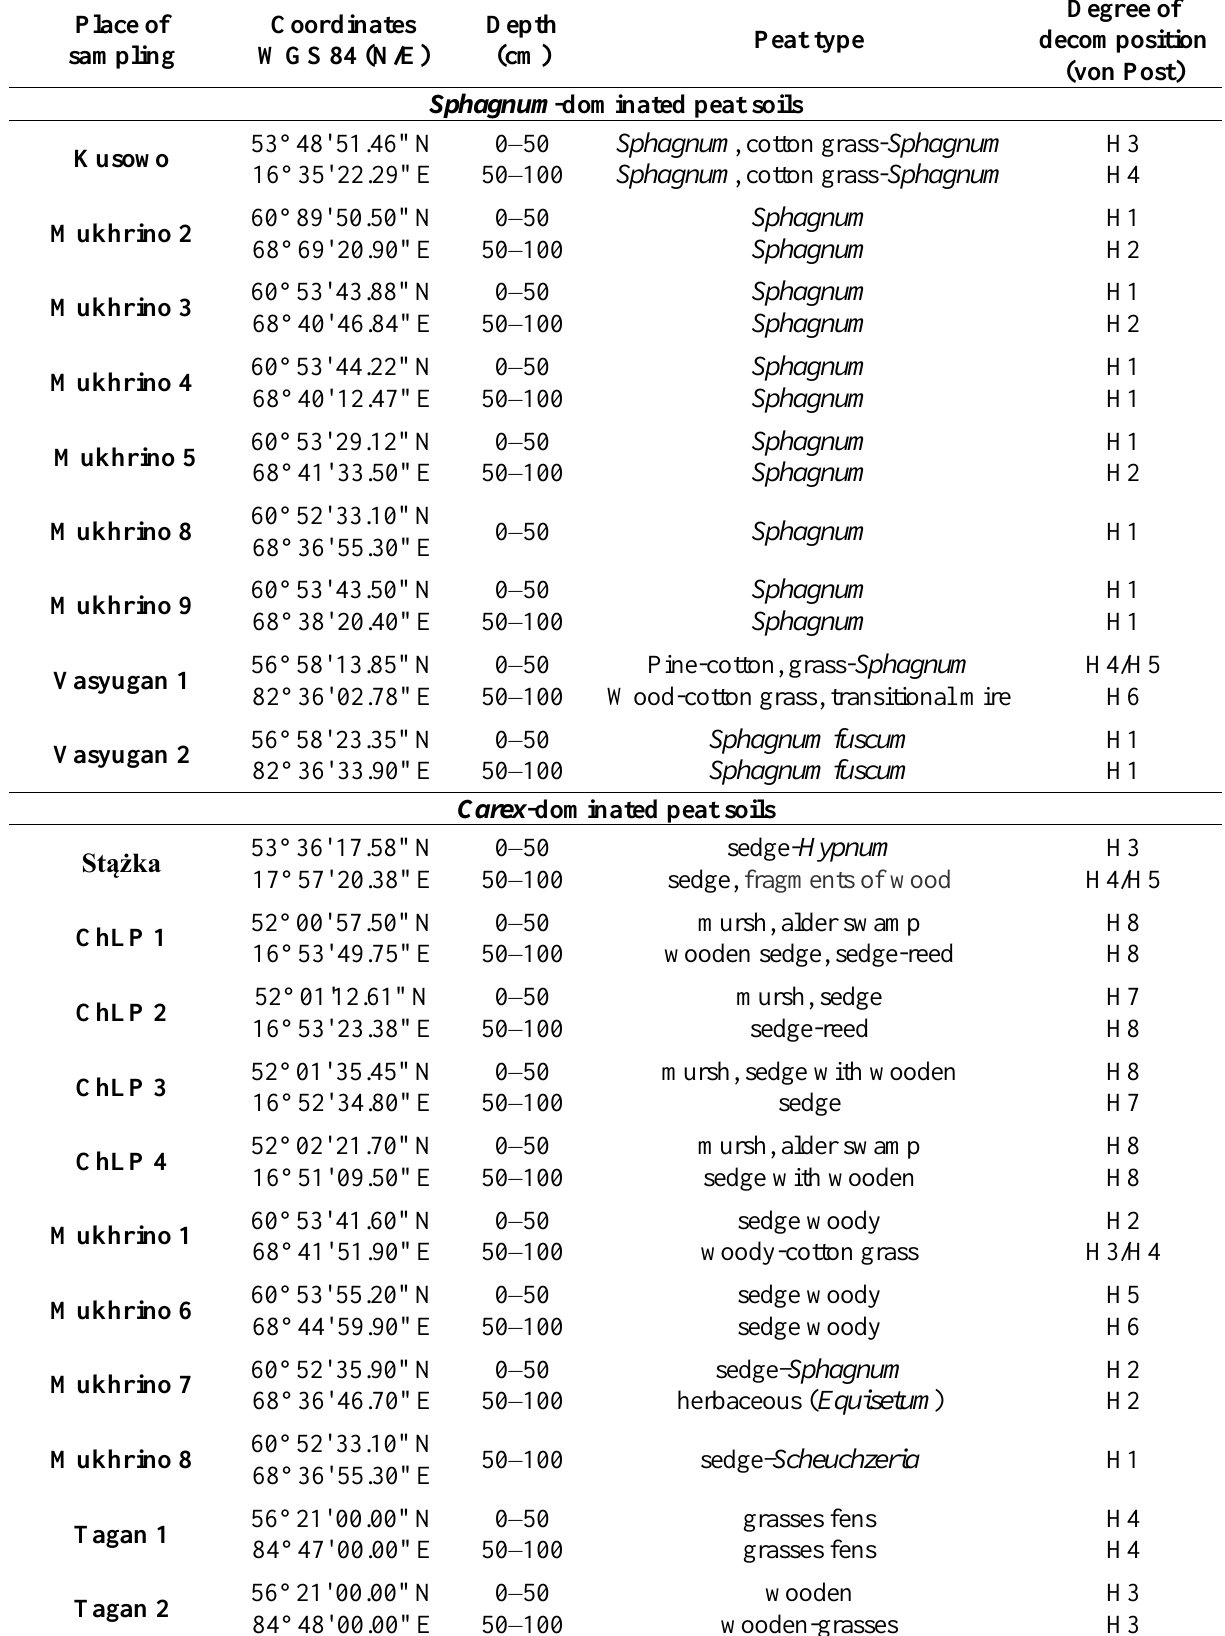
Table 1. Locations and general characteristics of the studied soils. ChLP = General Dezydery Chłapowski Landscape Park (sampling points